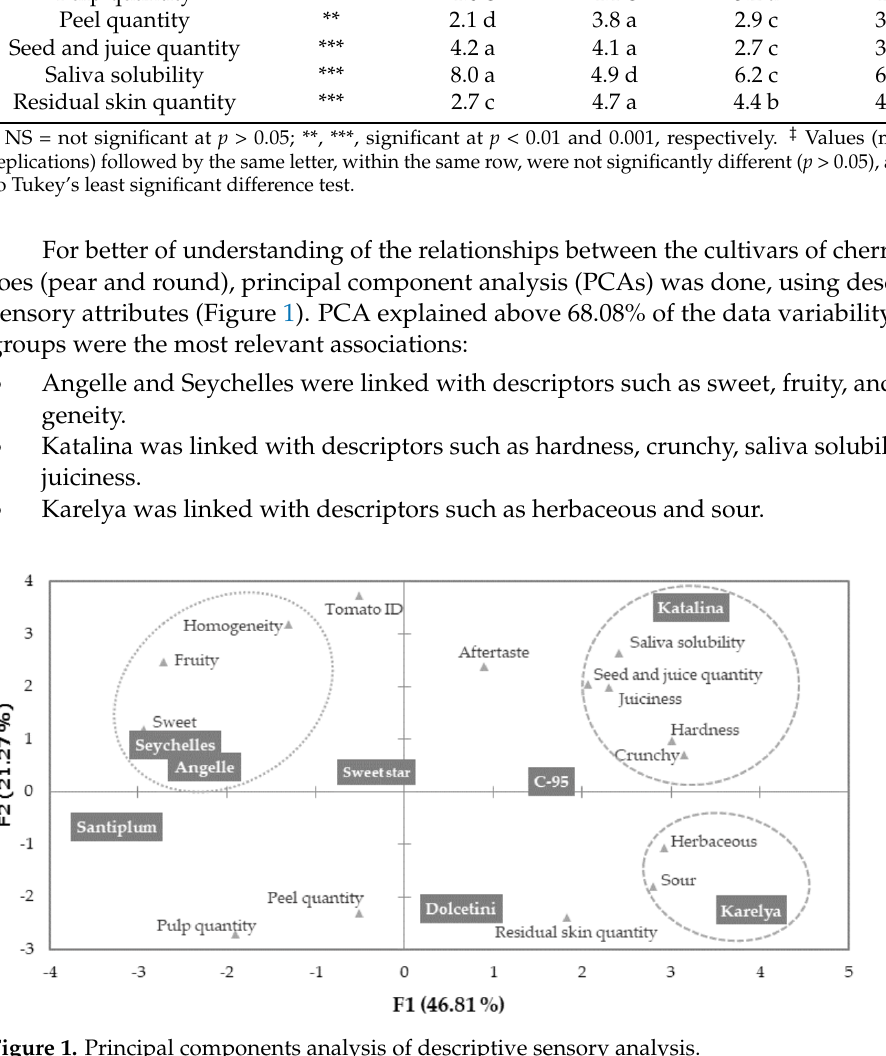
Figure 1. Principal components analysis of descriptive sensory